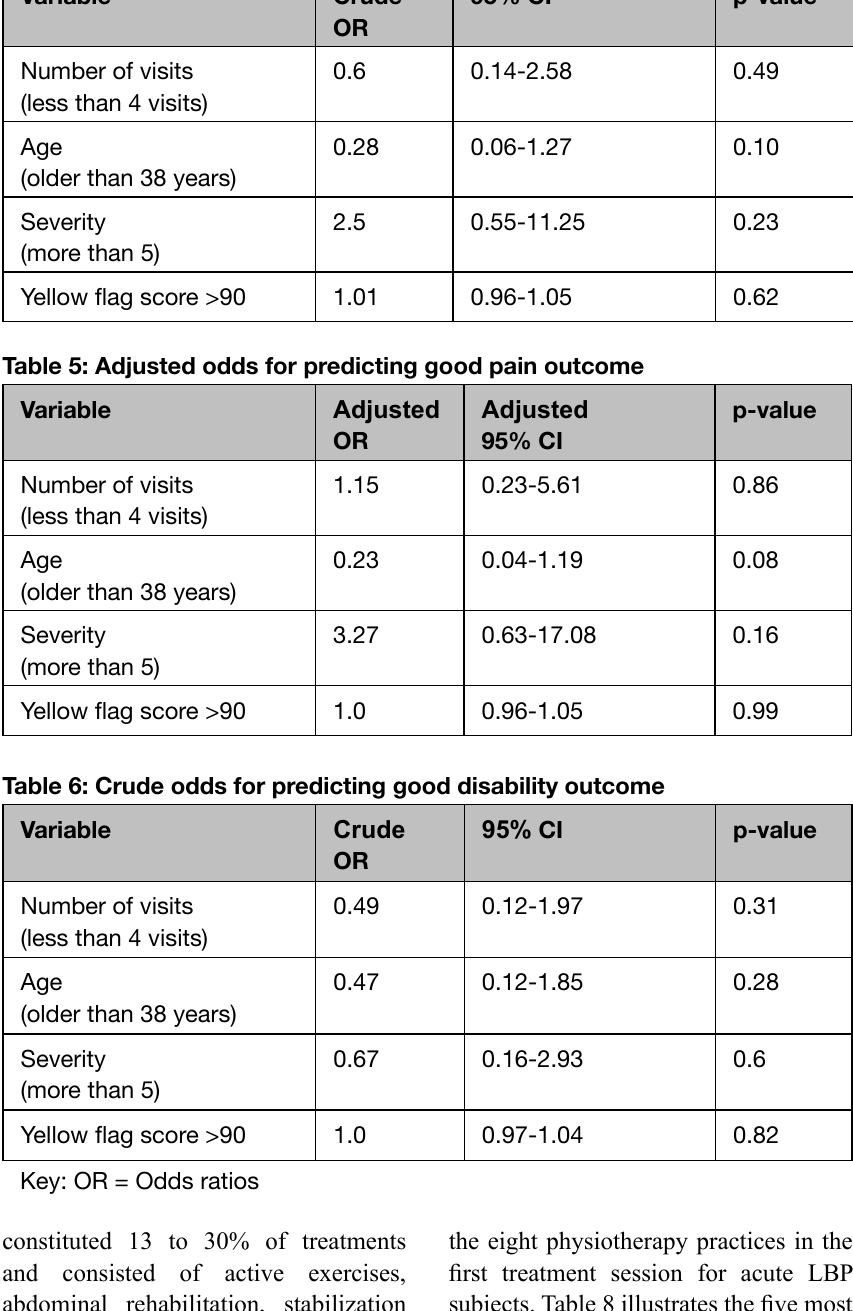
Table 4: crude odds for predicting good pain outcome variable